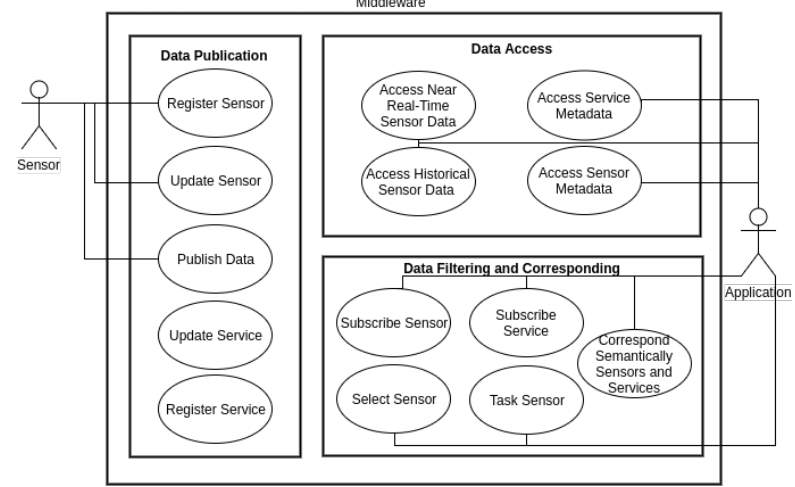
Figure 1. Use Cases Diagram—Middleware requirements.